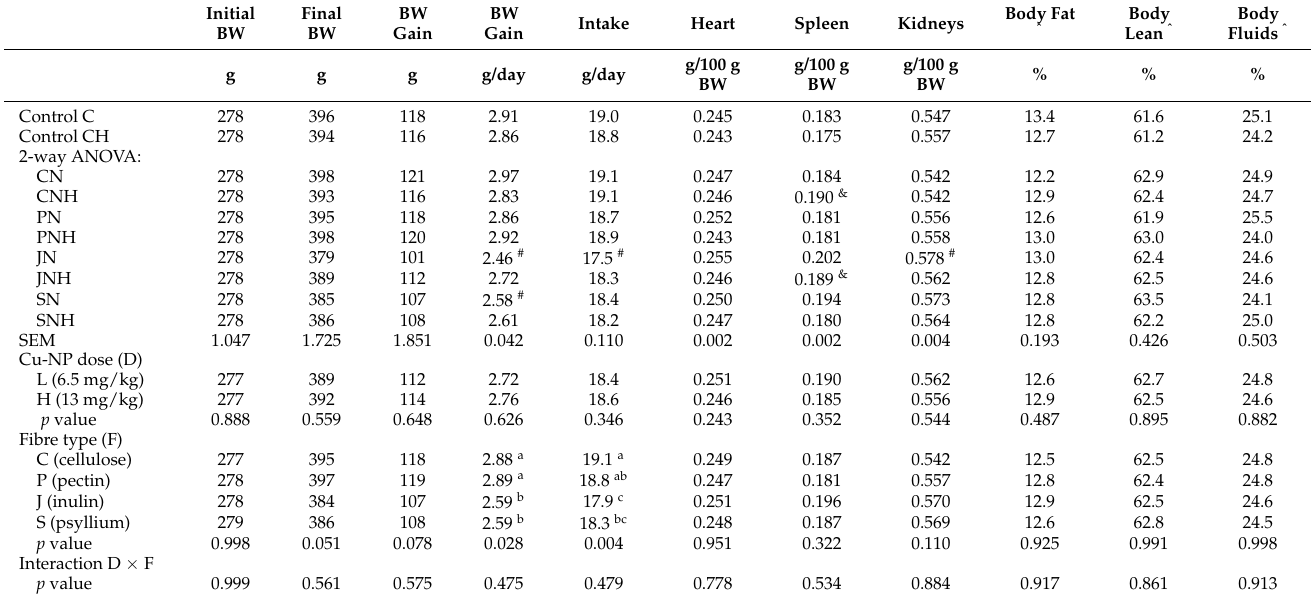
Table 3. Body weight, feed intake, NMR body composition and internal organs weight in rats fed experimental diets (n = 10 per group)